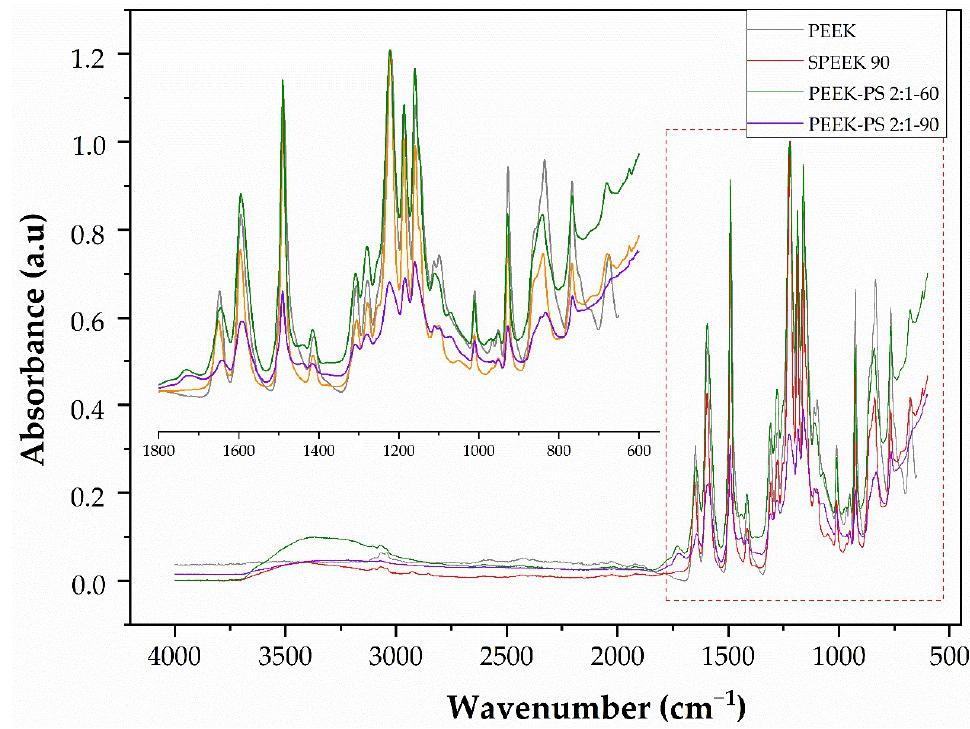
Figure 6. Comparative FTIR spectra of PEEK, SPEEK 90, PEEK-PS 2:1-60, and PEEK-PS 2:1-90.